Question: Draft a figure caption describing what is shown.
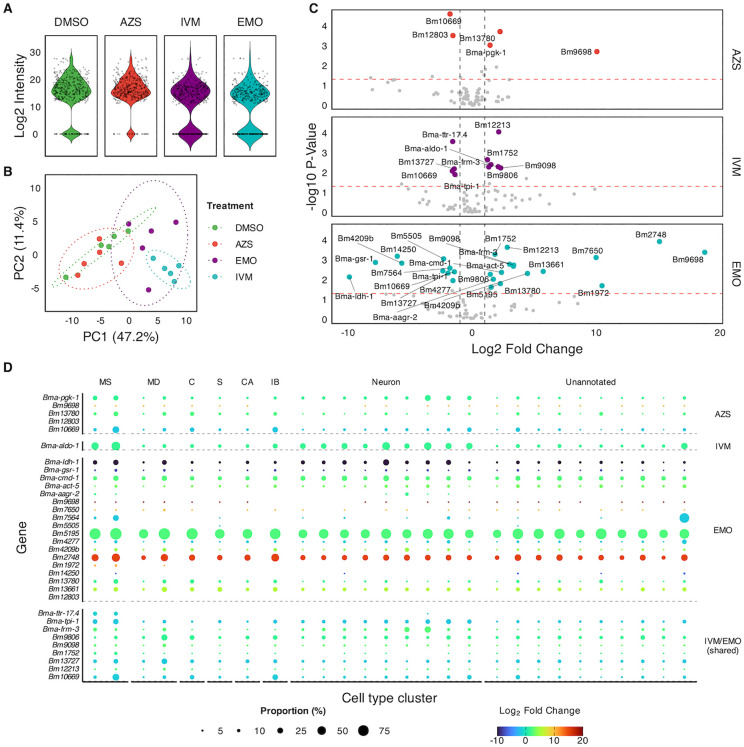
Answer: Effects of anthelmintics on the adult female secretory profile. (A) Violin plot representing the log 2 transformed peptide ion intensities distribution of all protein samples analyzed by mass spectrometry. Five biological replicates (reflecting parasite cohorts) were carried out, each representing secretions pooled from 12 adult females (6 wells) for each treatment condition. (B) Principal component analysis showing variance among replicates, color-coded by treatment. (C) Volcano plots representing the p-value and log 2 fold change (FC) associated with protein intensities 48 hours post 100µM AZS (red), 1µM IVM (blue), and 250nM EMO (purple) compared to 1% DMSO control. Red and grey dashed lines represent p-value < 0.05 and |log 2 FC| > 1, respectively. Colored points represent differentially expressed proteins of interest (|log 2 FC| > 1, p-value < 0.05, and FDR < 0.05). (D) Dotplot representing differentially expressed B. pahangi ES proteins post drug treatment mapped to single-cell gene expression patterns of one-to-one orthologs defined using B. malayi mf [ 57 ]. Cell annotations associated with cell type clusters are shown at the top (MS: muscle, MD: mesoderm, C: coelomocyte, S: secretory, CA: canal associated, IB: inner body), with dot size reflecting the proportion of cells within that cluster expressing the transcript of interest and dot color reflecting log 2 FC of protein abundance compared to DMSO. Differentially expressed proteins unique to each drug condition, as well as those shared between IVM and EMO, are plotted using either treatment-specific log 2 FC (unique) or mean log 2 FC (shared proteins).